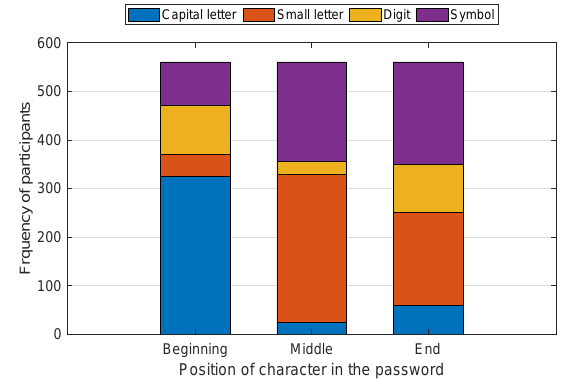
Figure 5. Potential position of various character